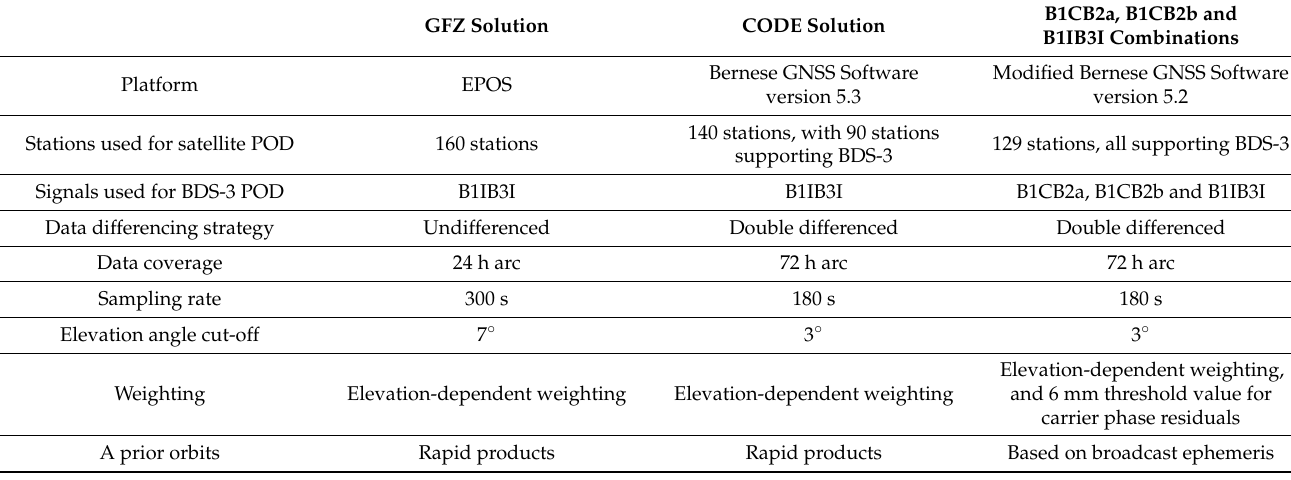
Table 2. BDS-3 satellite POD strategy and important aspects for GFZ solution, CODE solution and B1CB2a, B1CB2b and B1IB3I